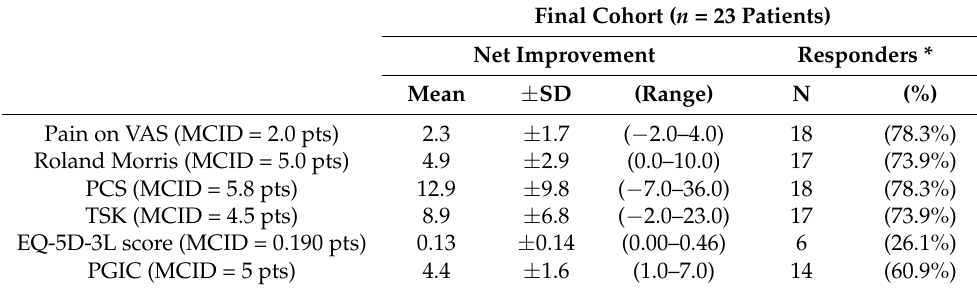
Table 3. Responder rate according to MCID values.